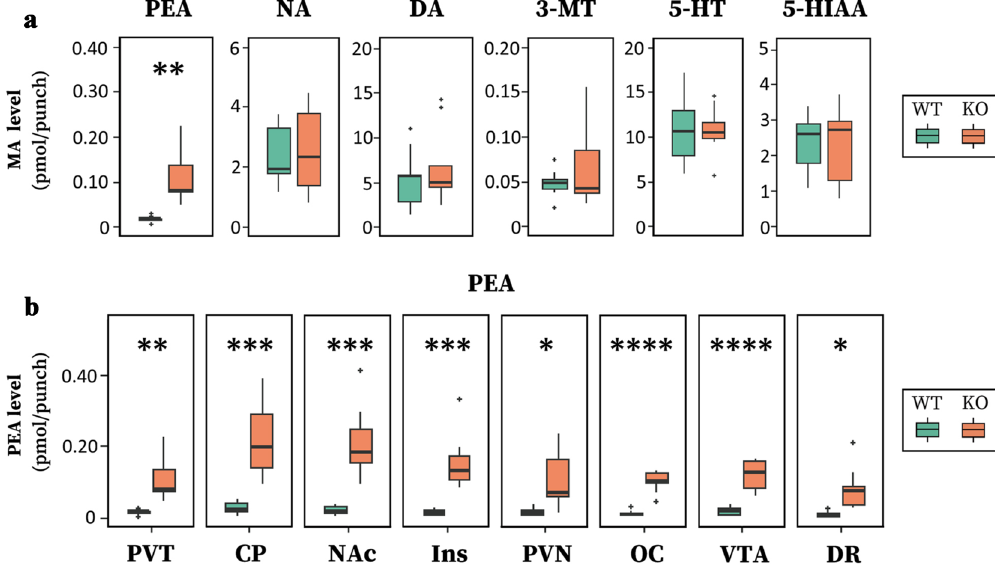
Figure 3. PEA levels are elevated in the PVT and other brain regions in global Maob KO mice. ( a ) MAs, trace amines, and their metabolites in the PVT of wild-type (WT, Maob (+/Y)) and Maob KO (KO, Maob (−/Y)) mice ( n = 9 for each group). The amounts of substances are described as pmol/punch. Boxplots show five statistics: median (horizontal bar), first and third quartiles (lower and upper hinges), and largest and smallest values no further than the 1.5-fold interquartile range (upper and lower whiskers). Data beyond the 1.5-fold interquartile range are plotted individually as outliers. ( b ) PEA levels in the PVT and other brain regions of WT and